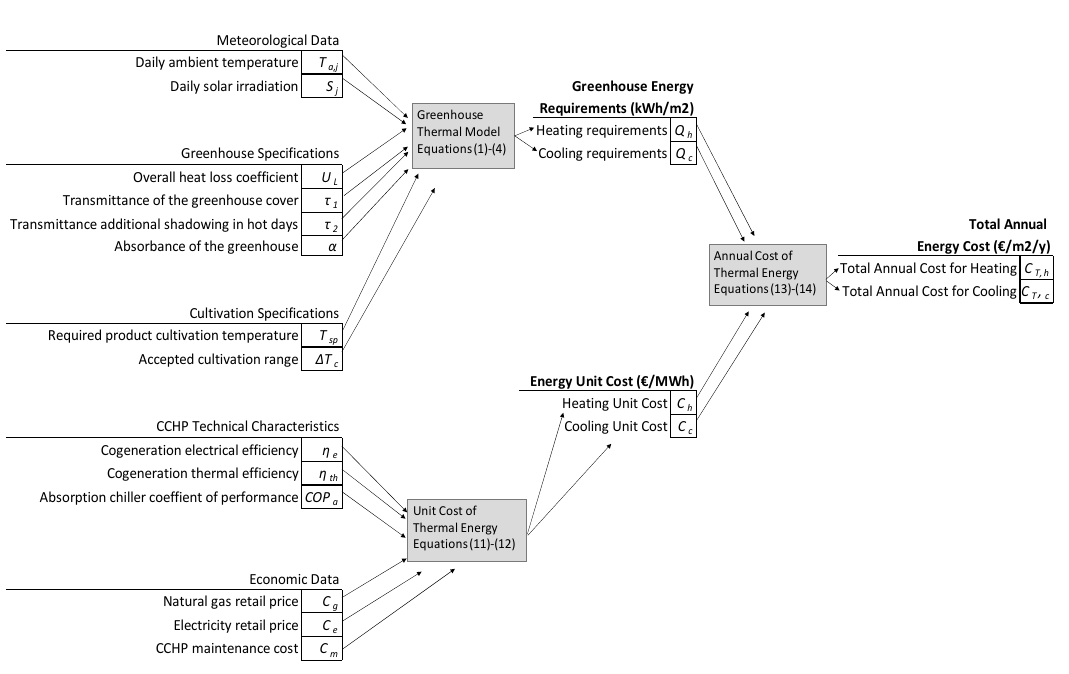
Figure 3. Information flow diagram of the proposed mathematical model.